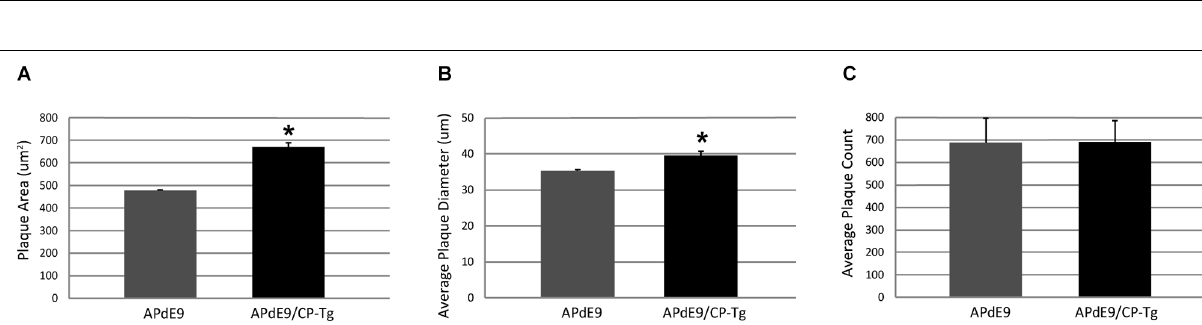
FIGURE 5 | Prostacyclin overexpression increases A β production. PBS- (A) and RIPA-soluble (B) A β 40 and A β 42 levels in APdE9 mice with prostacyclin overexpression. Bars are means ± SEM, n = 10 mice per group. * p < 0.05 compared to control (non-transgenic and CP-Tg) mice. # p < 0.05 compared to APdE9 mice. A two-way ANOVA with a Tukey’s HSD post hoc was used to determine significant differences.